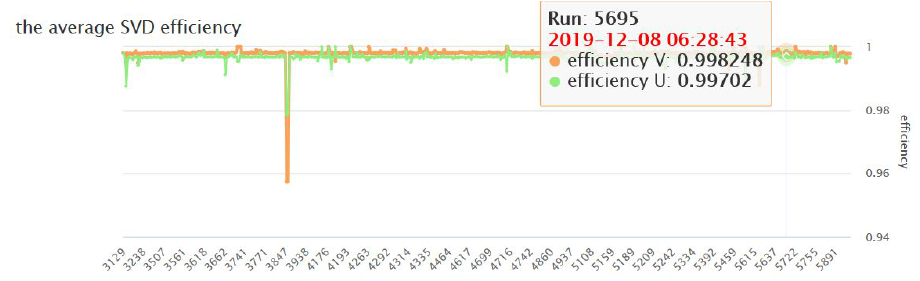
Figure 5. Run-by-run comparison for SVD e ffi ciency in u and v strips. Highlighted run 5695, 8 December